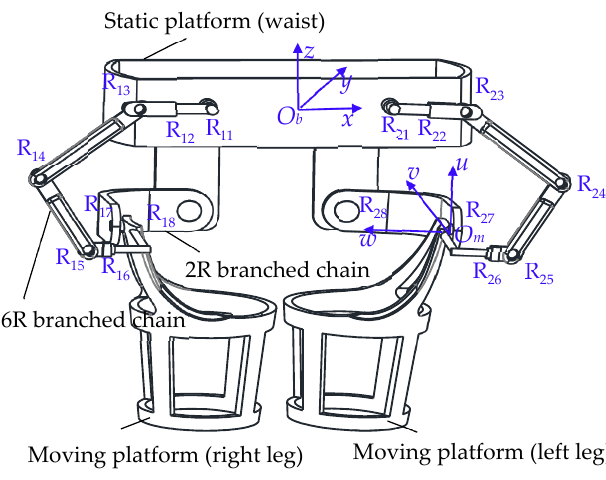
Figure 1. Model of hip joint rehabilitation mechanism and coordinate system.